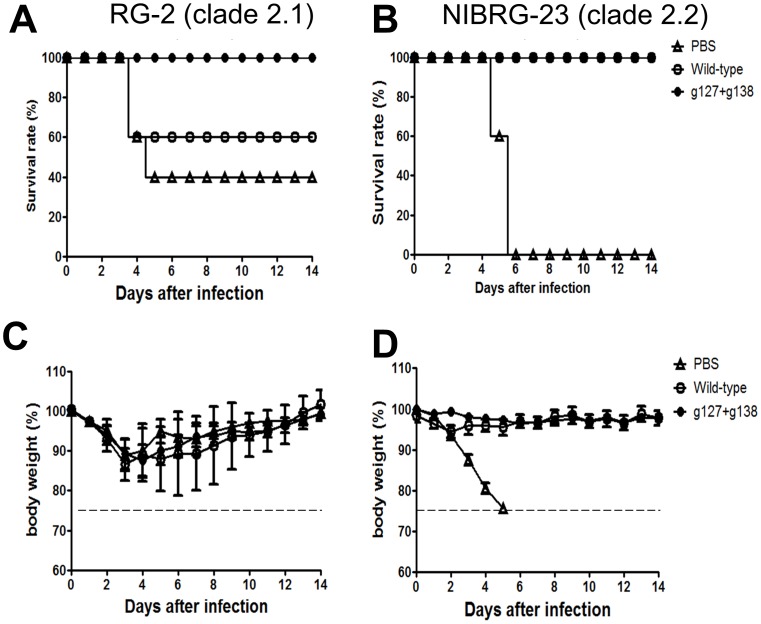
Protective immunity against influenza viruses challenges.The immunized mice were intranasally challenged with the reassortant RG2 (clade 2.1) or NIBRG23 (clade 2.2). After virus challenge, survival and body weight were recorded for 14 days. The body weight of each immunized group was presented as mean ± standard deviation. Over 25% body weight loss was regarded as an end-point.